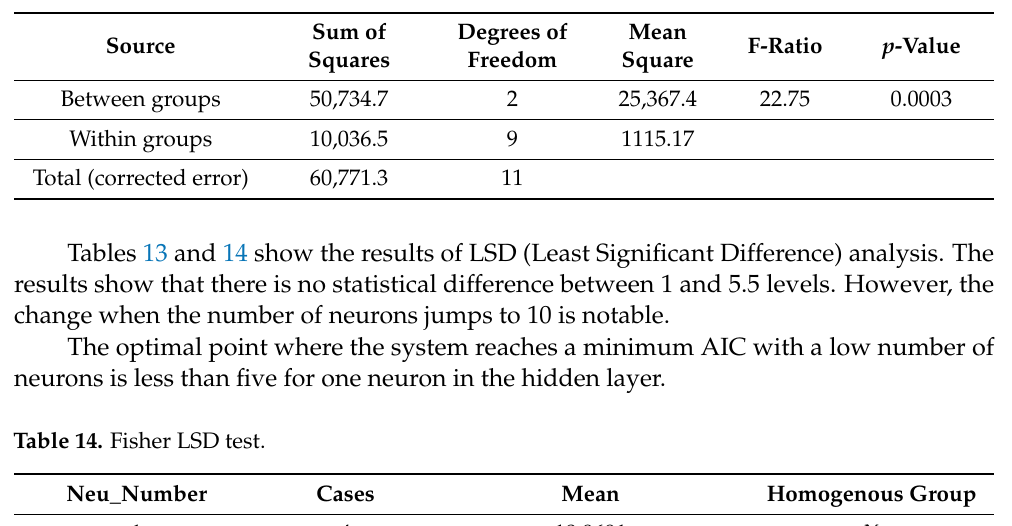
Table 13. ANOVA for C Factor (number of neurons).